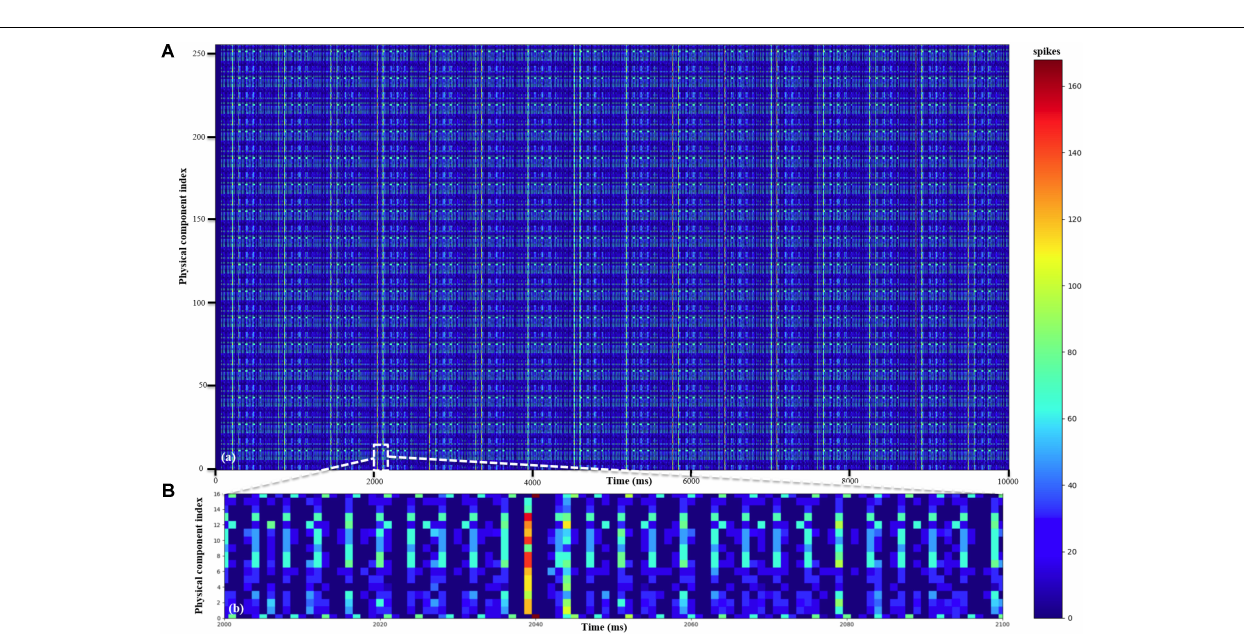
FIGURE 11 | Performance of LIF neurons. (A) The mean firing rates of all the 256 physical components. (B) The mean firing rates of the 16 physical components of one neural engine (Neural_engine[0] in Figure 9 ) from 2 to 2.1 s.